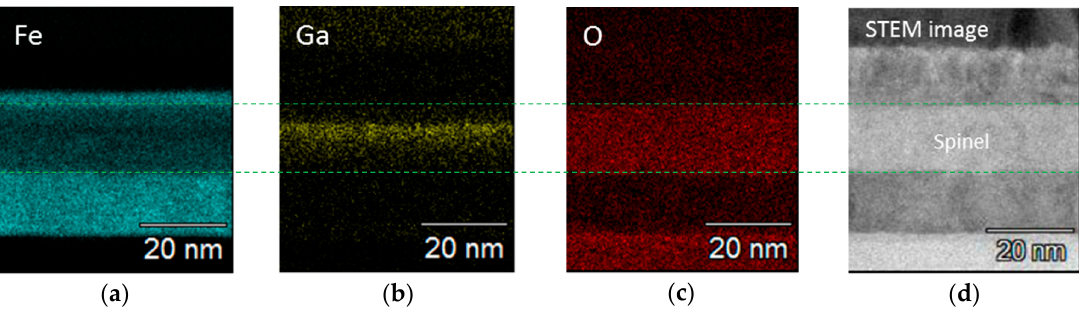
Figure 4. Elemental mappings of ( a ) Fe, ( b ) Ga, and ( c ) O obtained from the MTJ without the MgO underlying layer using an energy-dispersive X-ray spectroscopy (EDX); ( d ) bright-field scanning TEM image of the same area. Broken lines indicate the interfaces between the spinel layer and Fe electrodes.